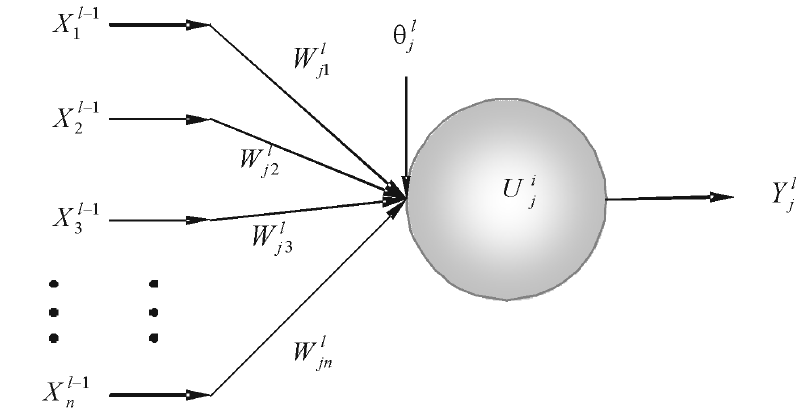
Fig. 2. Simplified schema of an artificial